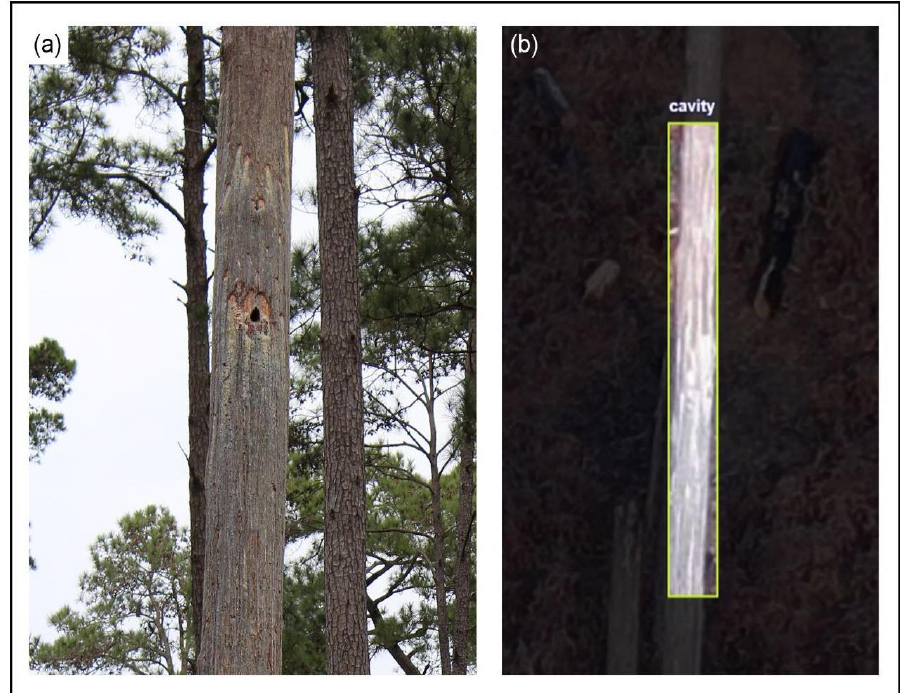
Figure 3. Comparison of ( a ) a cavity tree image from the ground and ( b ) a cavity tree ariel image from 76 m altitude. The former serves as an example of what resin wells look like visually but was not captured aerially or used for the study’s training sample dataset. While the resin wells are the most noteworthy feature of image objects, some also include discernible cavity entrances and red bark scaling.